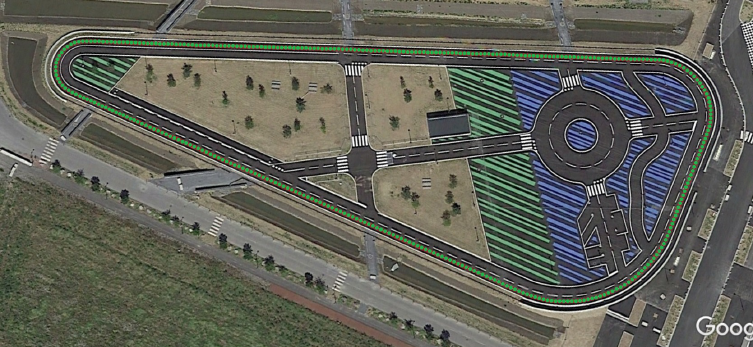
Figure 4. Reference map.